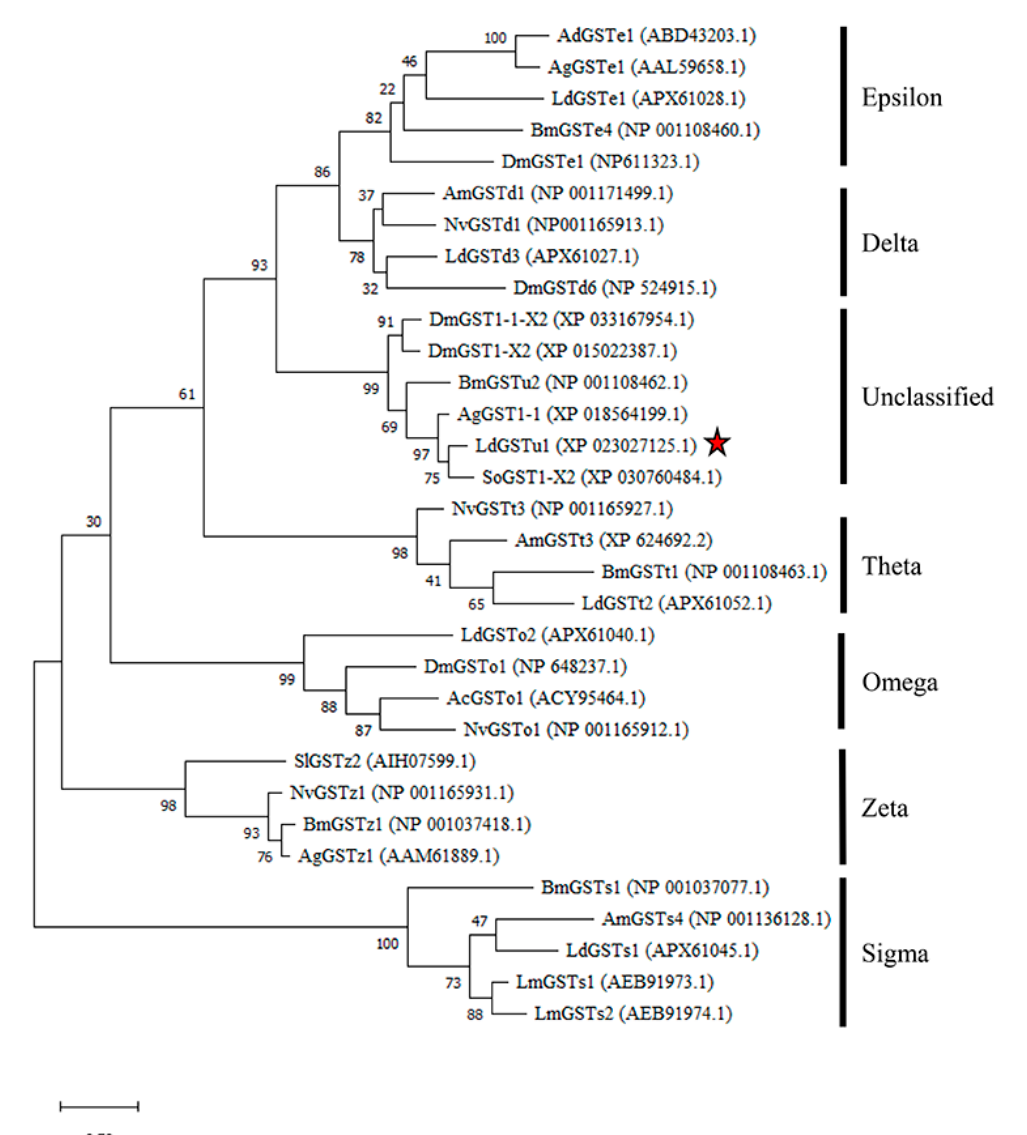
Figure 1. Phylogenetic analysis of LdGSTu1 with homologs in other insects. Ac , Anopheles cracens ; Ad , Anopheles dirus ; Ag , Anopheles gambiae / Anoplophora glabripennis ; Am , Apis mellifera ; Bm , Bombyx mori ; Dm , Drosophila mauritiana / Drosophila mojavensis / Drosophila melanogaster ; Ld , Leptinotarsa decemlineata ; Lm , Locusta migratoria ; Nv , Nasonia vitripennis ; Sl , Spodoptera litura ; So, Sitophilus oryzae . The red star indicates LdGSTu1.